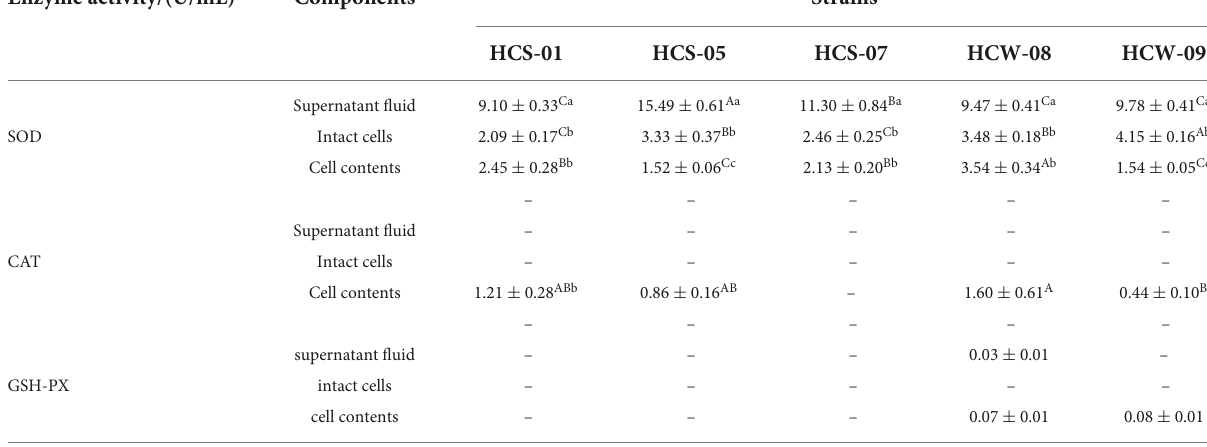
TABLE 2 Enzyme activity of each component of lactic acid bacteria. Enzyme activity/(U/mL)